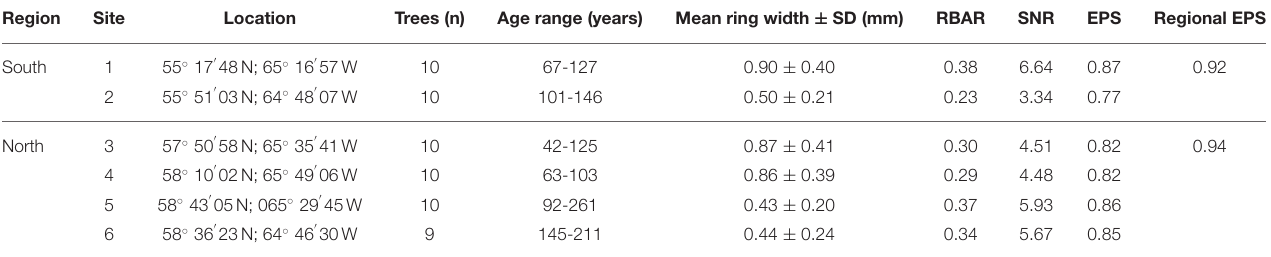
RBAR is the correlation between series, SNR is the signal-to-noise ratio and EPS is the expressed population signal.